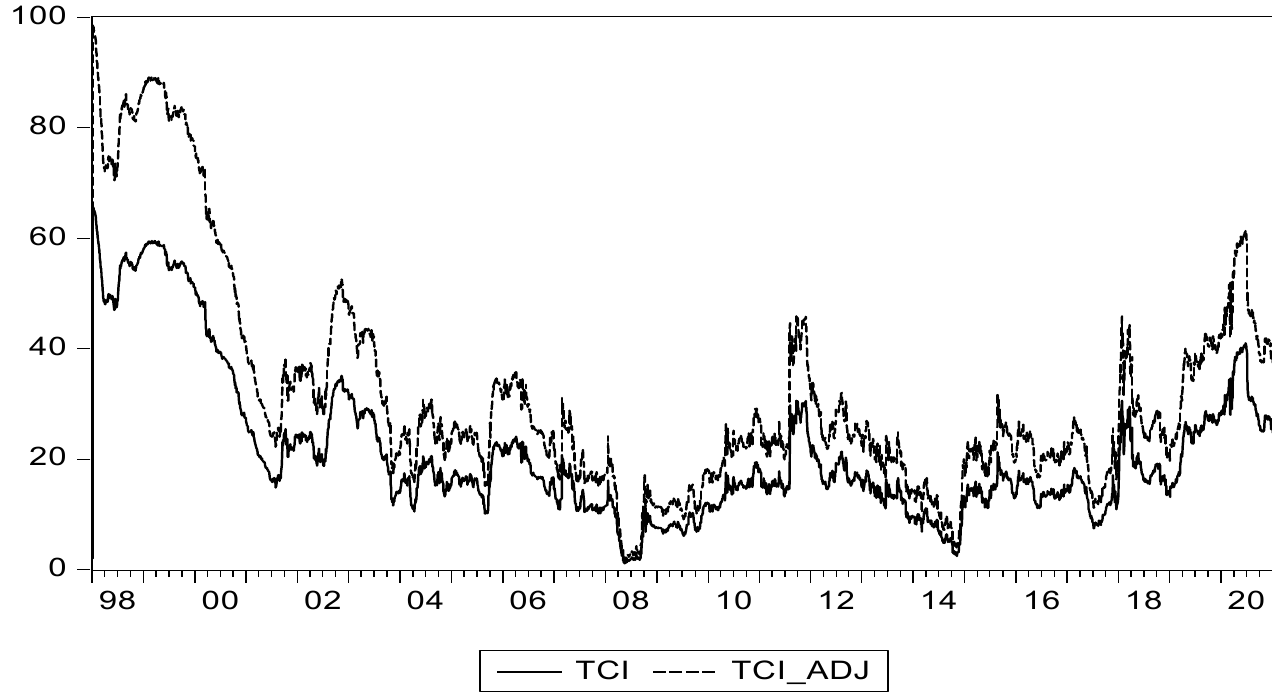
Figure 3. Total and Adjusted Connectivity Index.